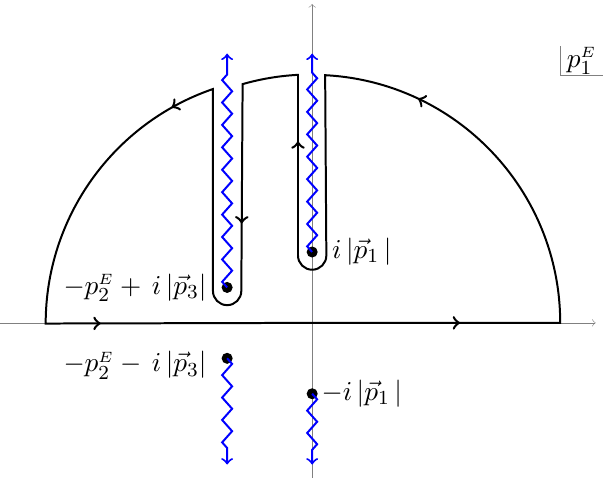
Figure 3 . Closed contour of integration for the p E 1 integral. The contribution from the arc at infinity vanishes, so the integral along the real axis is equal to that on each side of the two branch cuts on the upper-half